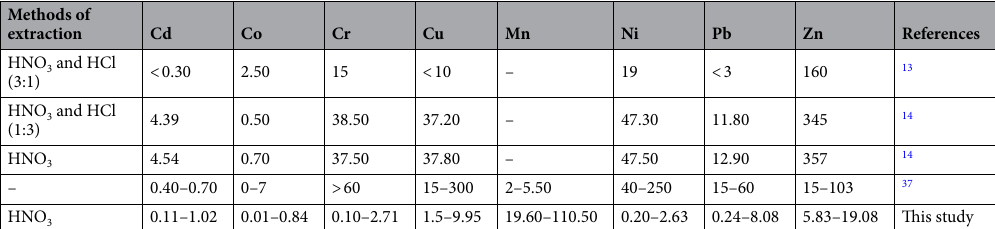
Table 3. The total heavy metal concentration (mg kg −1 ) in wood ash by different authors regarding the method of extraction. ’’–’’ no data; bottom ash of wood chips, sawdust, bark, and peat 13 ; flay ash of wood chips 14 ; bottom wood ash 37 ; bottom wood pellet ash (this study).